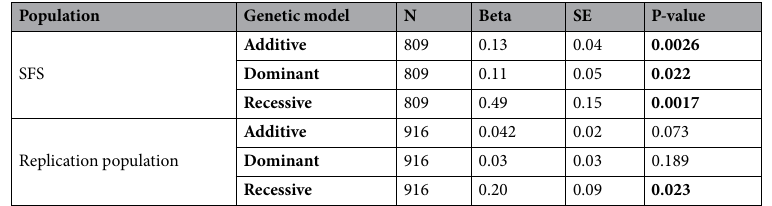
Table 5. Association analysis of the polymorphism rs6918289 with TNF- α levels in the discovery and